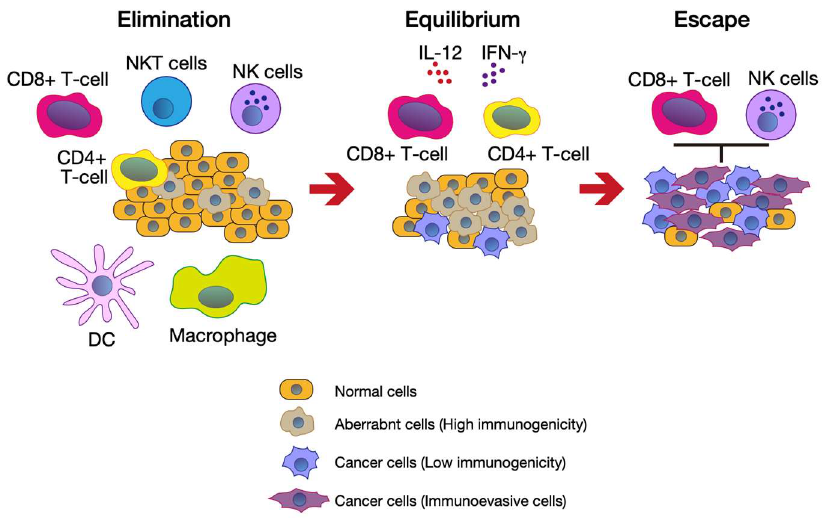
Figure 2. Cancer immunoediting. NKT cells, natural killer T cells; NK cells, natural killer cells; DC, dendritic cells. This figure was illustrated using Adobe Illustrator 2022 based on ref [4].